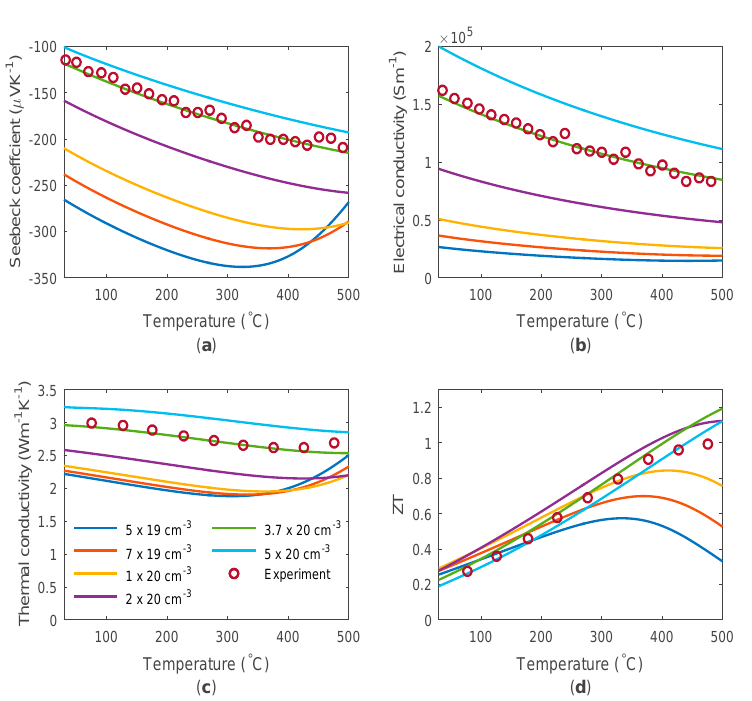
Figure 4. Modelled and experimental thermoelectric material parameters of n-type Sb doped Mg 2 Si 0.4 Sn 0.6 , as a function of temperature: ( a ) Seebeck coefficient; ( b ) electrical conductivity; ( c ) thermal conductivity; and ( d ) ZT. The modelled values are displayed for a number of different doping densities.